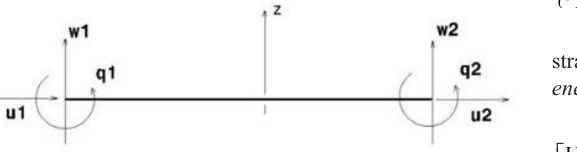
Figure 2. Two-node beam finite